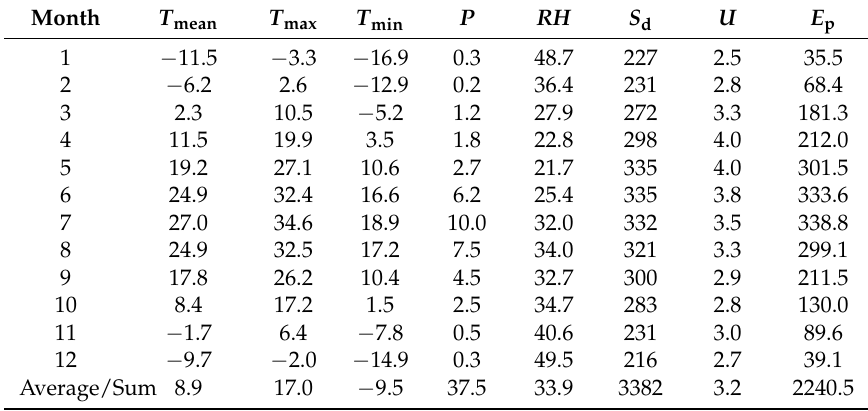
Table 1. Monthly change of climatic variables included the mean ( T mean , ◦ C), maximum ( T max , ◦ C), minimum ( T min , ◦ C) of air temperature, precipitation ( P , mm), relative humidity ( RH , %),